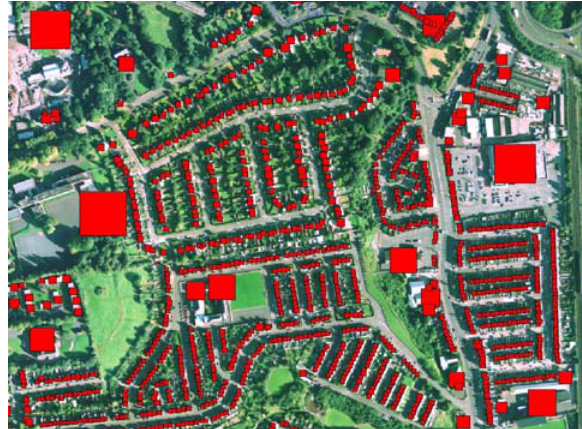
Figure 4: Temporal structural-functional model. Aerial photograph represents the urban structure of Belfast, UK in 2010 ( T 2 ), while postal data (POINTER database) represents residential function of the same area in 2000 ( T 1 ). Figure 5: Evidence of a temporal lag between structure and